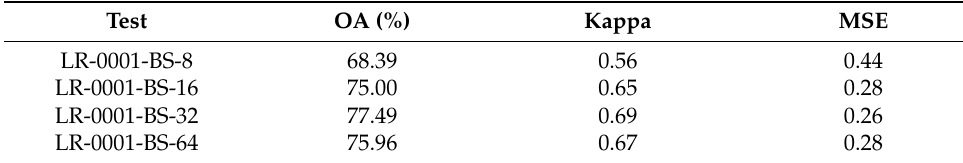
Table 4. The effects of different batch sizes on model classification accuracy.